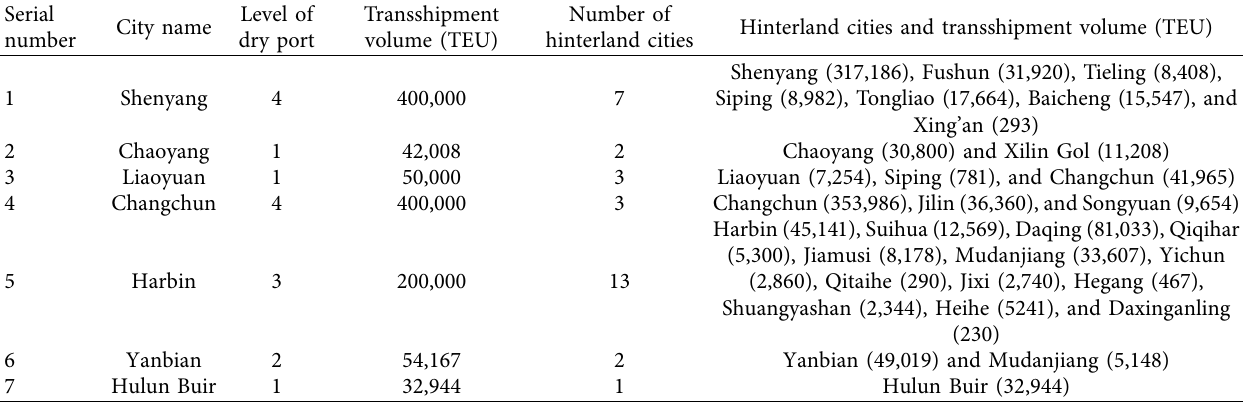
Table 11: Construction of the dry port under the RD-RL-RD